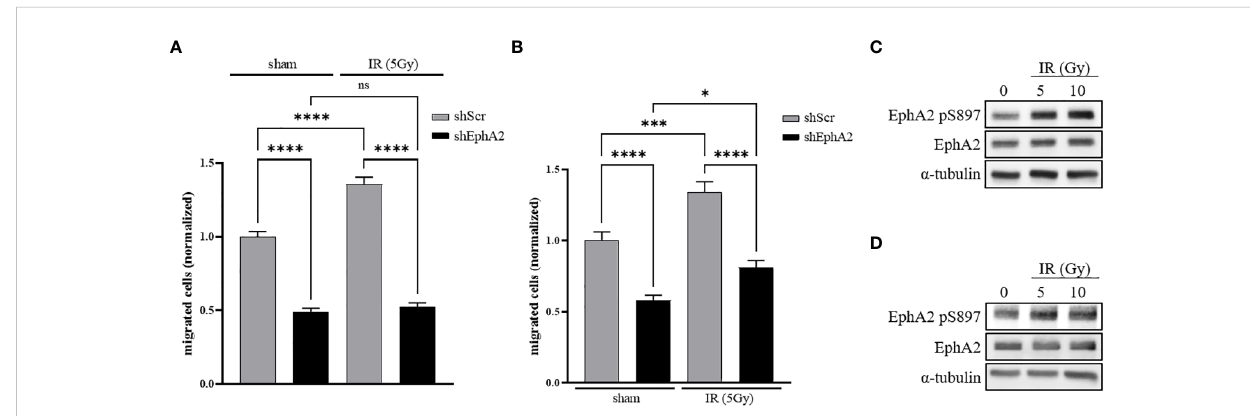
FIGURE 1 IR-induced cancer cell migration is dependent on EphA2. (A) A doxycycline-inducible shRNA system directed against EphA2 (shEphA2; or scrambled control, shScr) was used to assess the effect of IR and EphA2 downregulation on the migratory capacities of NCI-H358 tumor cells. (B) CM derived from irradiated and sham-irradiated control cells were used to attract NCI-H358 cells in dependence of their EphA2 status (shScr and shEphA2, respectively). (C) Increase in EphA2 pS897 in NCI-H358 cells 48h after irradiation with 5 and 10 Gy. (D) Increase in EphA2 pS897 in naïve NCI-H358 after incubation with CM derived from sham-irradiated and irradiated NCI-H358 cells. Bar graphs represent the average number of migrated cells counted in three randomly chosen fi elds/transwell of three independent experiments. *, P < 0.05; ***, P < 0.001, ****, P < 0.0001. ns, not signi fi